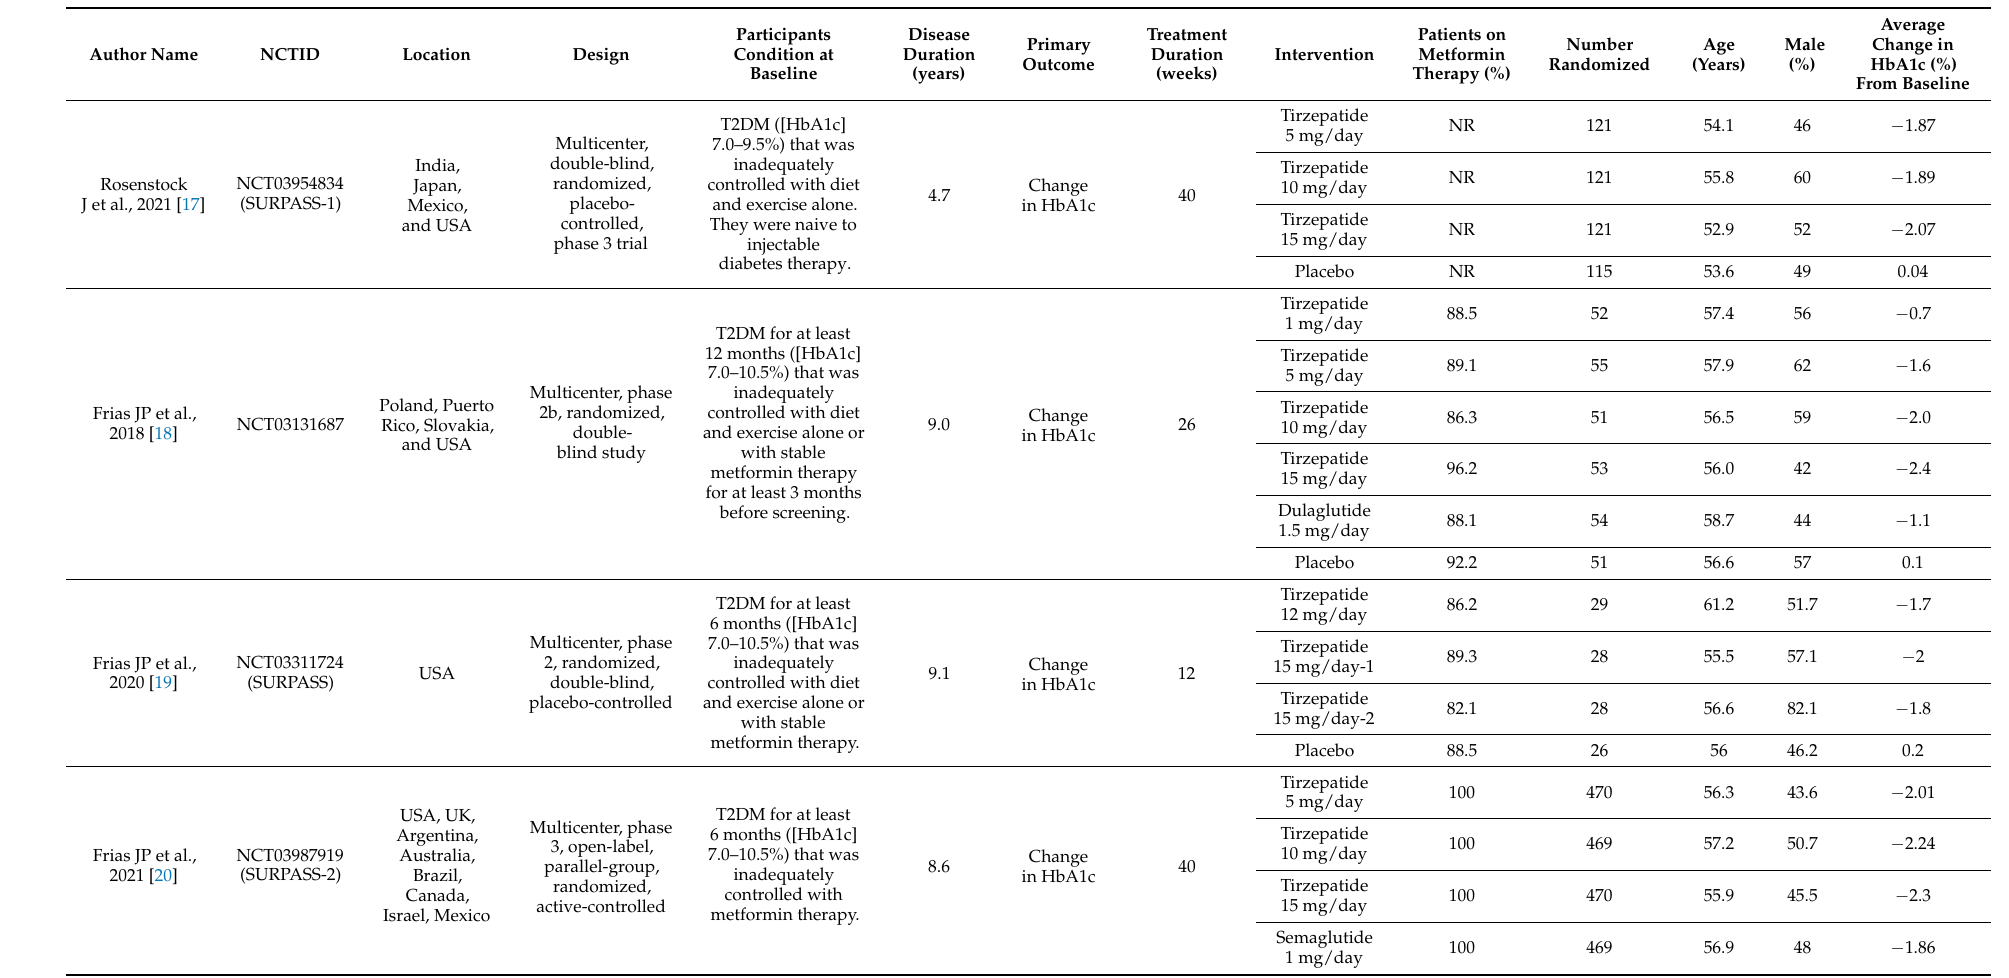
Table 1. Study characteristics of included